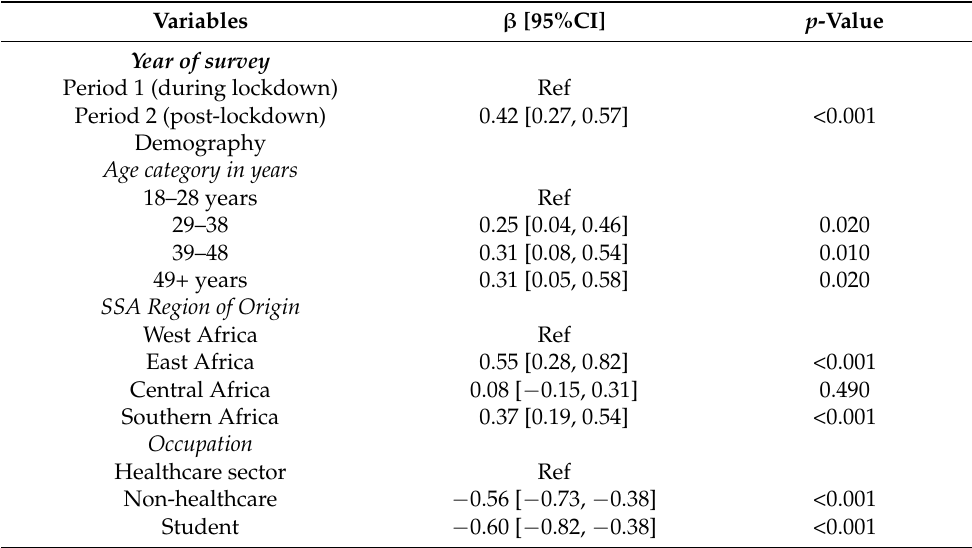
Table 3. Factors associated with perceived risk of contracting COVID-19 in sub-Saharan